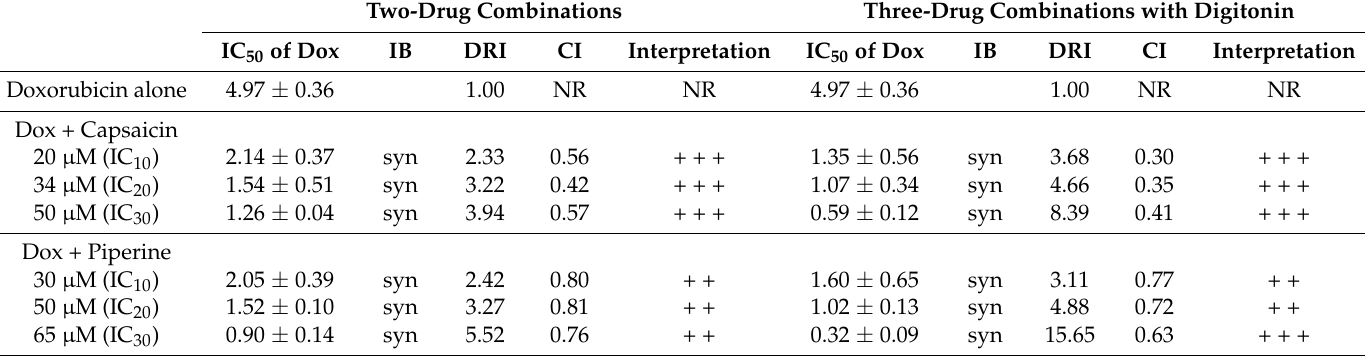
Table 3. Cytotoxicity of doxorubicin against CEM/ADR 5000 cells, either alone or in two-drug or three-drug combinations. The IC50 ( µ M) are presented as the mean ± SD. 0.3 < CI < 0.7 synergism (+ + +), 0.7–0.85 moderate synergism (+ +), 0.85–0.9 slight synergism (+). NR—not relevant. IB—isobologram. DRI—dose reduction